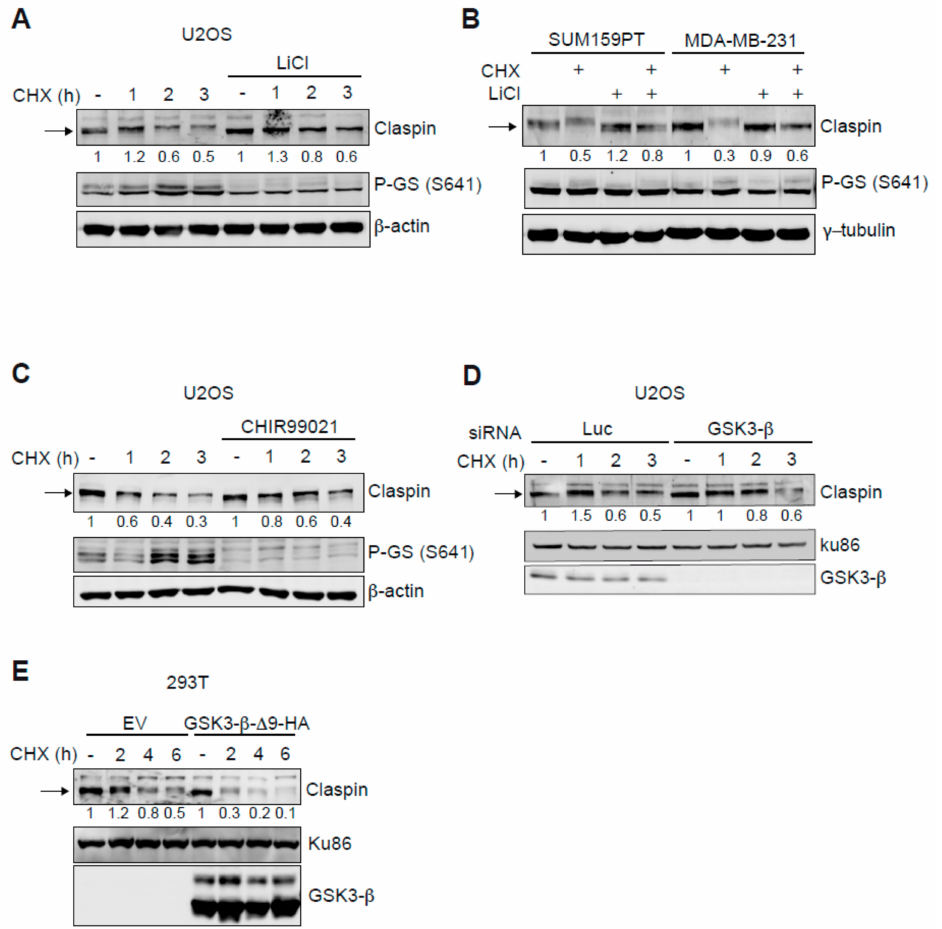
Figure 1. GSK3- β inhibition increases Claspin protein stability. U2OS ( A ) and TNBC cells